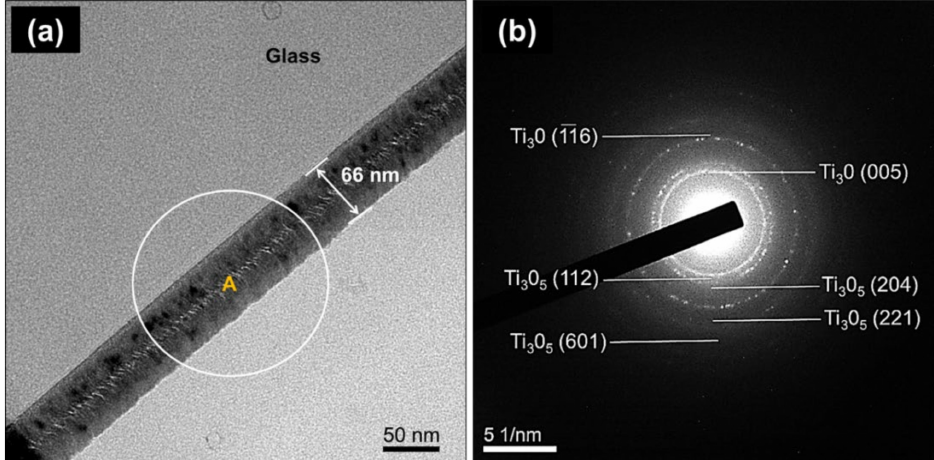
Figure 3. Cross-sectional HR-TEM images of Ti 3 O x thin-film sample deposit at 2.5 kW ( a ) bright-field of the film with a thickness 66 nm. The image (inset A) was selected for electron diffraction analysis, and ( b ) the selective area diffraction pattern of section “A” adjacent to Ti 3 O and Ti 3 O 5